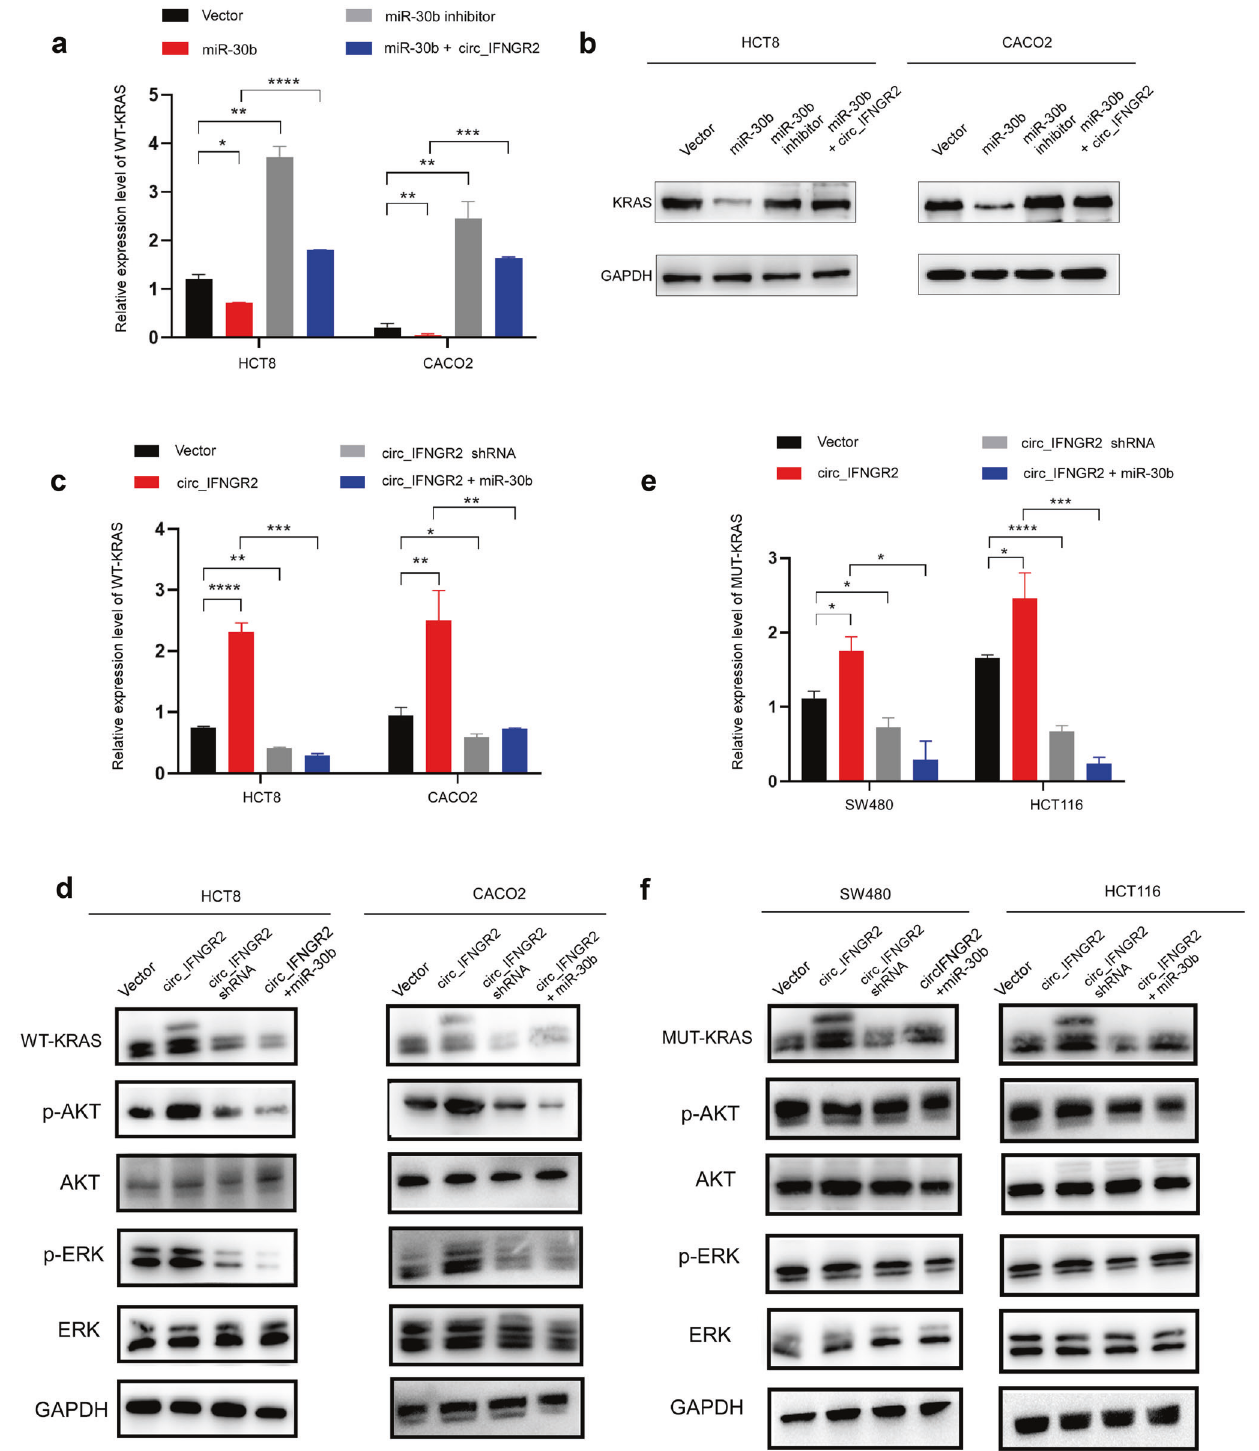
Fig. 5 circIFNGR2 sponges miR-30b to reduce KRAS expression. a RT-qPCR was used to detect the relative expression level of WT-KRAS in the indicated cells. b Western blotting was performed to determine the protein expression of WT-KRAS in the indicated cells c , e RT-qPCR was used to detect the relative expression level of WT-KRAS in the indicated cells. d , f Western blotting was performed to determine the protein expression of KRAS and its downstream proteins. The error bars represent the means ± SDs from three independent experiments. * p < 0.05, ** p < 0.01, *** p < CRC cells, while in the MUT-KRAS CRC patients, circ_ IFNGR2 contributed little to the cetuximab resistance for the persistently activated downstream signaling of KRAS. What is more, in the WT- could upregulate the expression of KRAS, activating the down- KRAS cell lines, the number of apoptotic cells in the control group stream AKT signaling and promoting the cetuximab resistance of